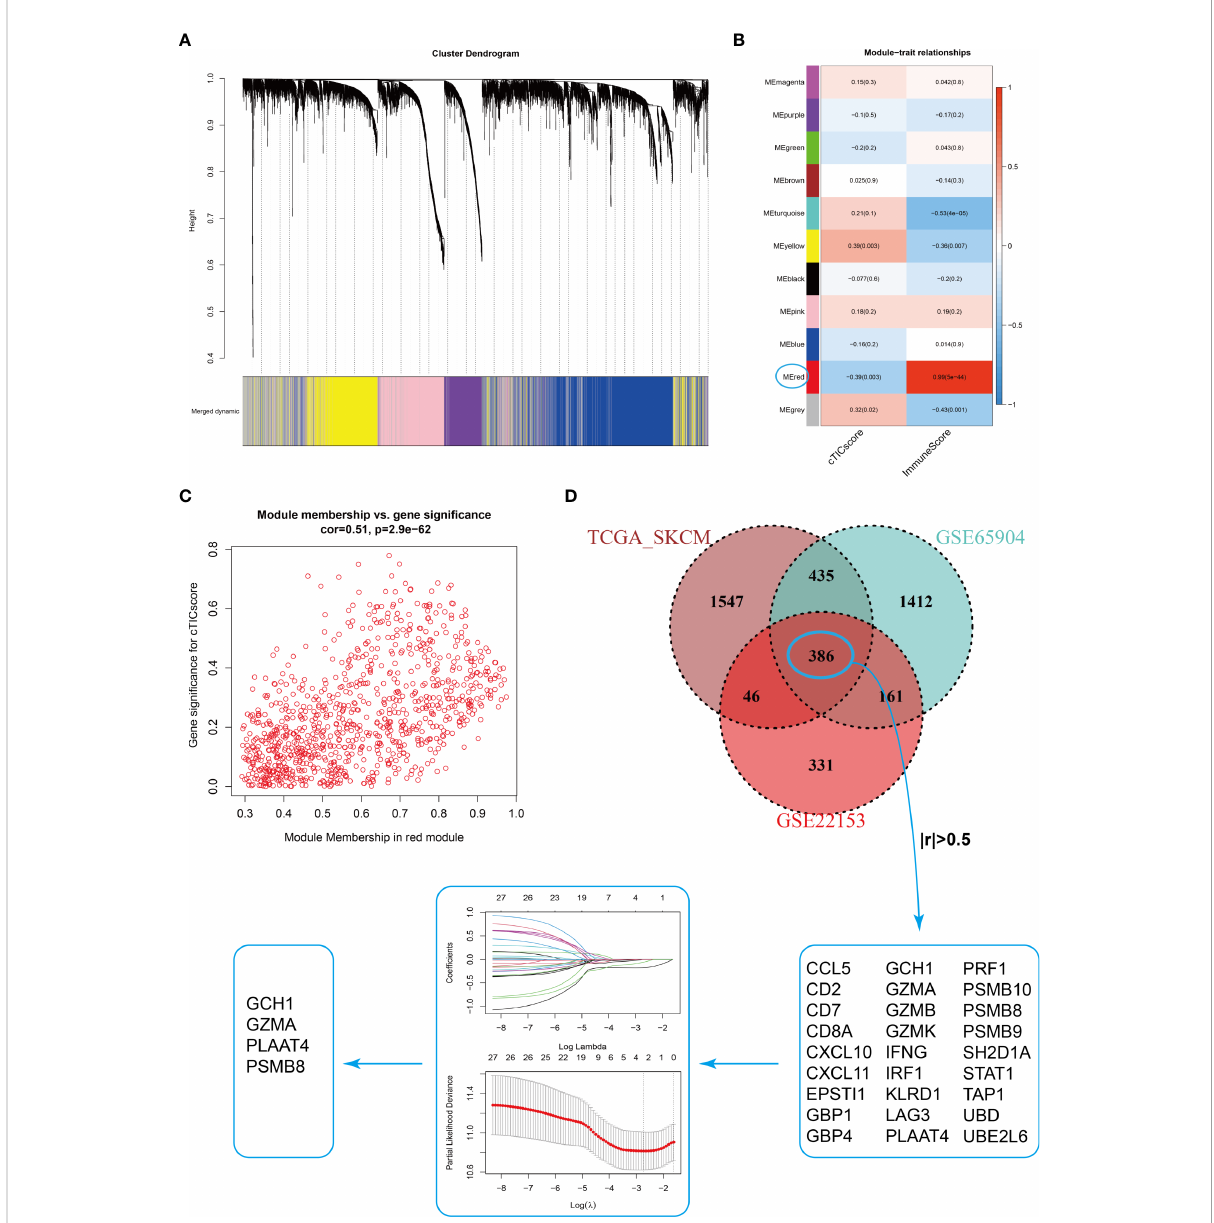
FIGURE 2 Identi fi cation of four signature genes in CM TME. (A) Merging of mRNA co-expression modules. (B) Correlation heatmap of module genes and cTICscore or Immunescore in the GSE22153 dataset. The correlation coef fi cient changed from – 1 to 1 as the color turned from blue to red gradually. (C) Scatterplot of the correlation coef fi cient between the selected module (red module) and the cTICscore. (D) Flowchart of the identi fi cation of four signature genes in CM TME. A total of 386 genes were shared in the selected modules from TCGA_SKCM, GSE65904, and GSE22153, and 27 of these genes strongly correlated (absolute coef fi cient > 0.5) in expression with the cTICscore across all three datasets. The 27 genes were input into a LASSO regression model, which generated four crucial genes for further